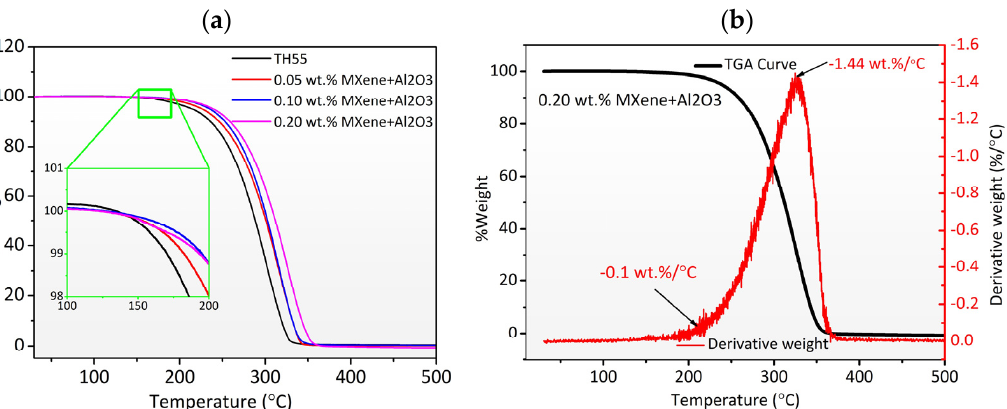
Figure 5. ( a ) Thermal decomposition as a function of temperature of pure Therminol55 and nanofluids at different MXene + Al 2 O 3 concentrations, ( b ) Derivative of TGA curve of 0.20 wt% MXene + Al 2 O 3 nanofluid.